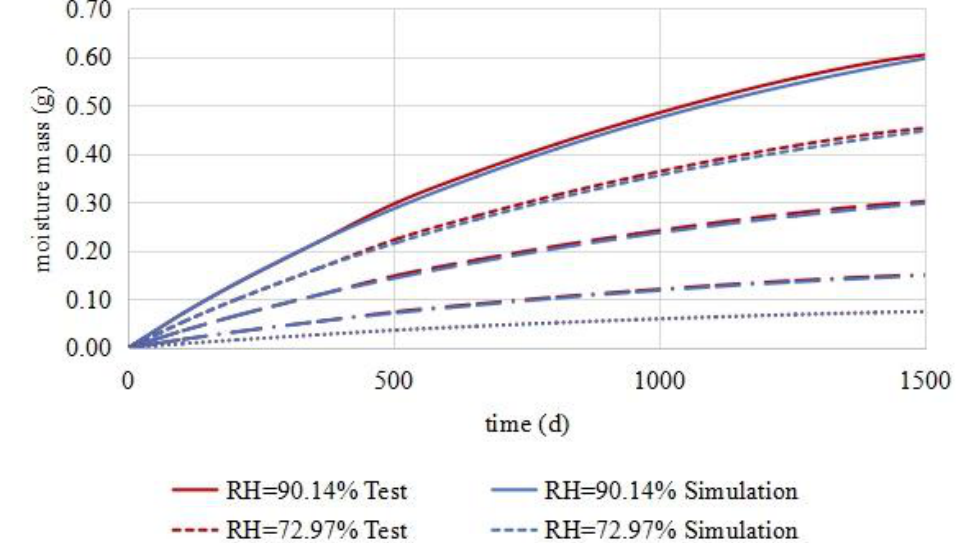
The average effective diffusivity of the moisture movement of the asphalt mixture was 5.0306 × 10 –4 mm 2 /s, which was substituted into Equation (18) to obtain the diffusivity of medium III, which was 0.8383 mm 2 /s. Using the finite element software COMSOL, the diffusivities of medium I, medium II, and medium III were brought into the numerical model. The simulation conditions were set to the test conditions shown in Table 9. After the simulation, the relationship between the water vapour increment of the model and time was derived, as shown in the blue curve in Figure 12. Then, the data obtained in the process of measuring the effective diffusivities of the asphalt mixture were plotted to demonstrate the relationship between the water vapour increment and time, as shown in the red curve in Figure 12. As seen in